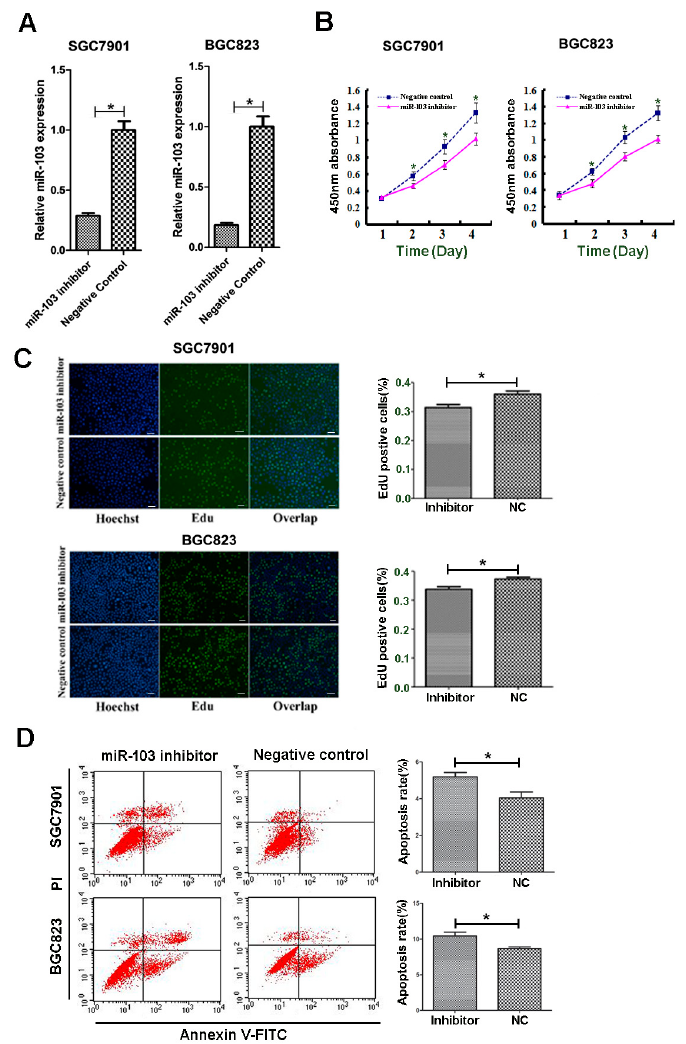
Figure 2. miR-103 promotes cell proliferation and reduced apoptosis of GC cells. ( A ) Analyses of miR-103 expression after transfection in SGC7901 and BGC823 cells by real-time PCR; ( B , C ) Influence of miR-103 downregulation on cell proliferation of SGC7901 and BGC823 cells by CCK-8 ( B ) and EdU assays ( C , D ) Influence of miR-103 knockdown on cell apoptosis. * p < 0.05, Scale bar = 100 µ m for ( C ); the data represent the mean ± SD from triplicate measurements.